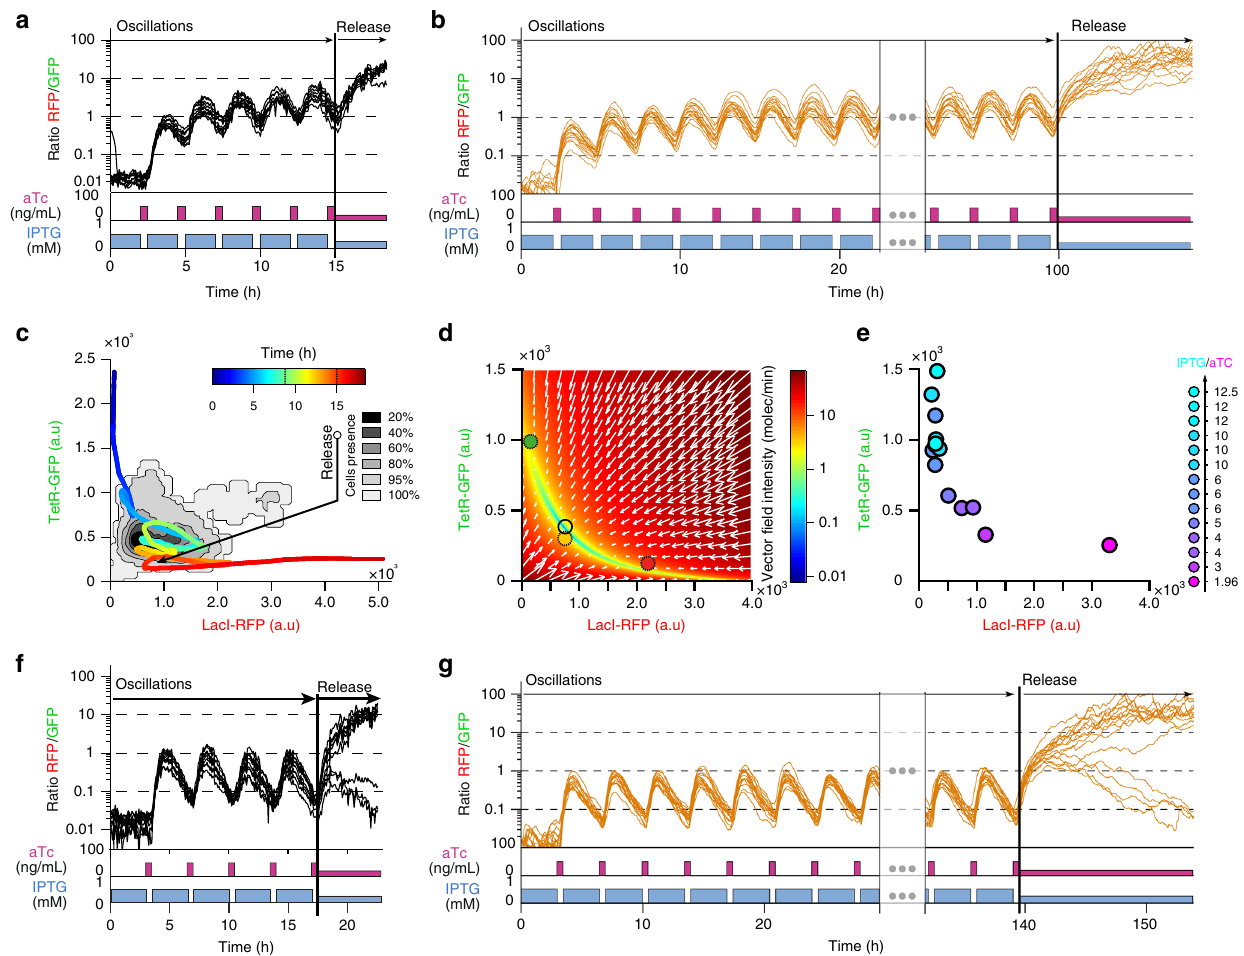
Fig. 4 A cell population can be maintained in a state of balanced expression using periodic stimulations. a . Ratio of LacI-RFP and TetR-GFP levels for observed cells ( n = 8). The concentrations of the inducers were varied periodically (120 min of 0.5 mM IPTG, 30 min of 50 ng ml − 1 aTc). In such dynamic conditions, the cells were kept in a state of balanced expression. As soon as the periodic stimulation was stopped, with aTc and IPTG set back to their reference levels, the cells were attracted to the RFP-dominant state. b In silico experiment, in which periodic stimulation was applied as in a to a simulated population of cells (n = 16) implementing a stochastic version of the toggle switch model and showing a similar behavior. c Experimental trajectory of one of the cells shown in a in the (LacI-RFP; TetR-GFP) state space. Cell probability of presence is shown for the time window (9 h < Time < 15 h). d Using the model, the vector fi eld in the state space averaged over time during an entire period of stimulation can be computed. The vector fi eld displays a single null point that acts like an effective global attractor (black circle). e The global localization of the cells in the state space during the oscillatory regime depends on the relative amounts of inducers. The average position of the cell population is represented for 14 different periodic stimulation experiments that differed by the total amount of IPTG and/or aTc used. The experiment depicted in ( a , c has a ratio of 4 (violet circle). f Experimental periodic stabilization for a different stimulation frequency (180 min of 50 mM IPTG, 30 min of 50 ng ml − 1 aTc, n = 11). Cells were stabilized at a lower ratio than in a . Interestingly, when the periodic stimulation was stopped, the cell population split into two groups, each attracted by a stable equilibrium state. This demonstrates that the cell population was close to the frontier between basins of attraction. g In silico periodic stabilization of a population of cells ( n = 16) for the same dynamic stimulation shown in f . See Supplementary Fig. 8 for additional